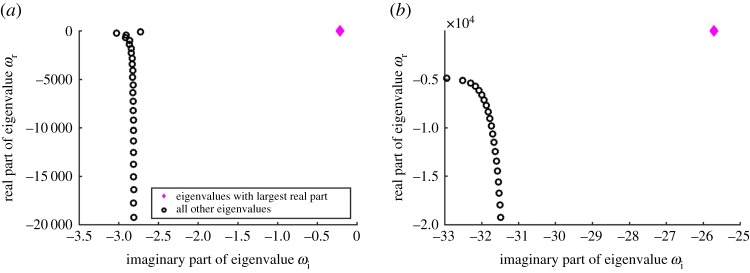
Plot of the eigenspectra for (a) k = 1 and (b) k = 20. The panels show the first 20–25 eigenvalues with the largest real parts. θ = 0.01, Re = 20, L = 10−3, α = 10−3. (Online version in colour.)